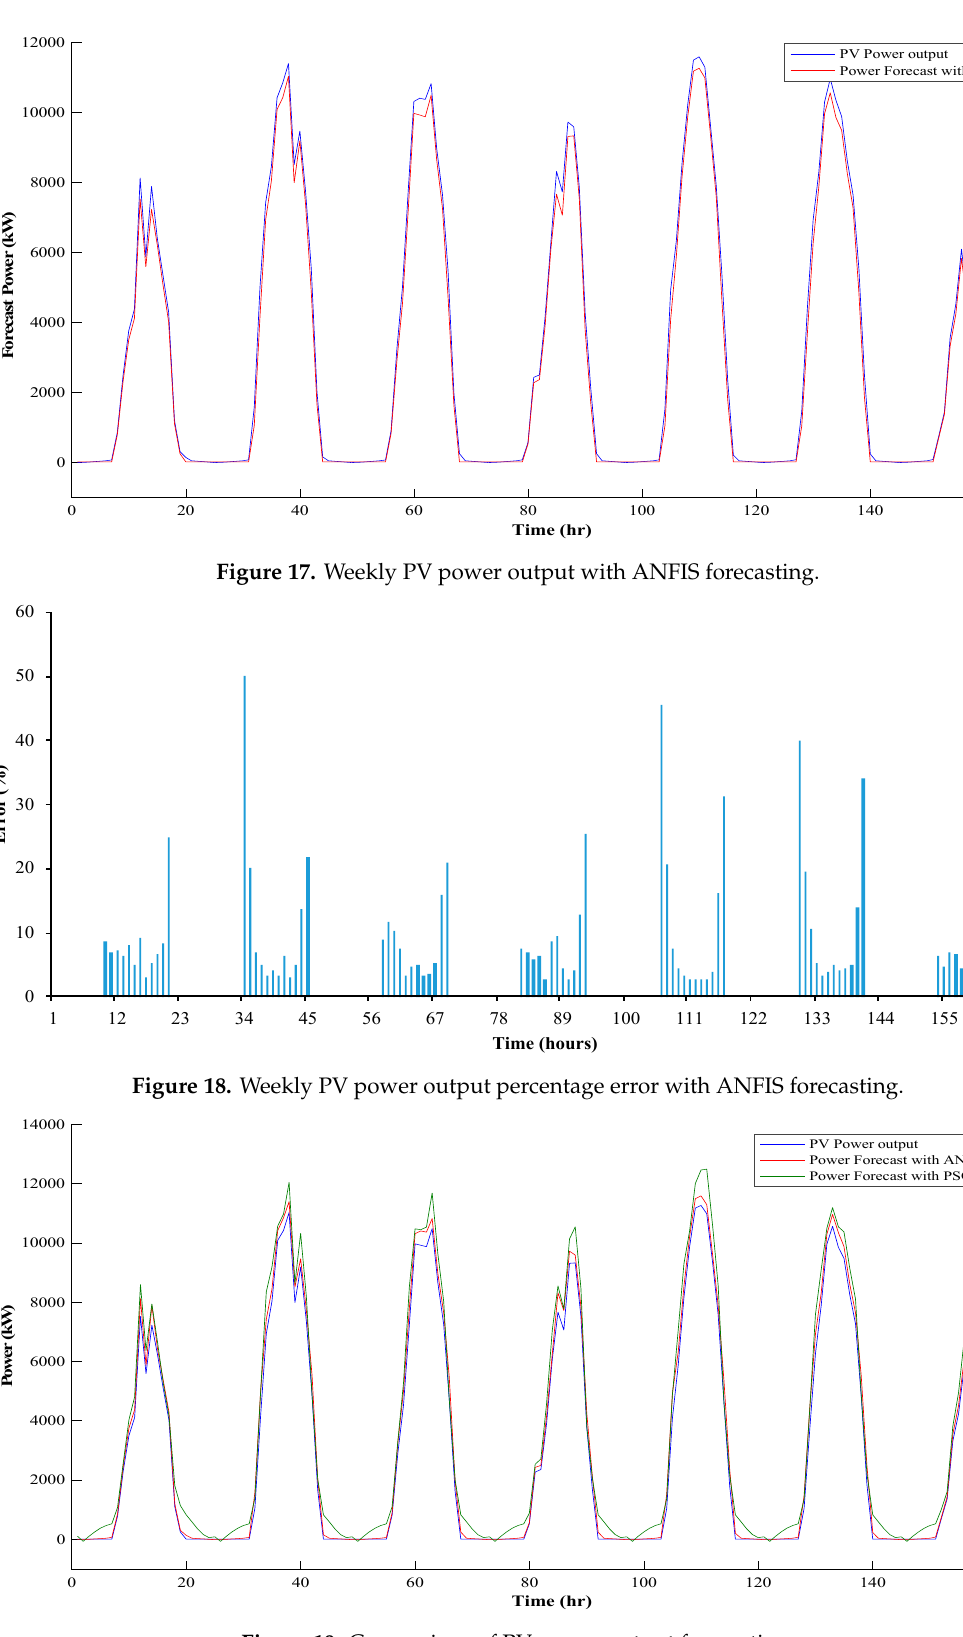
Figure 19. Comparison of PV power output forecasting.